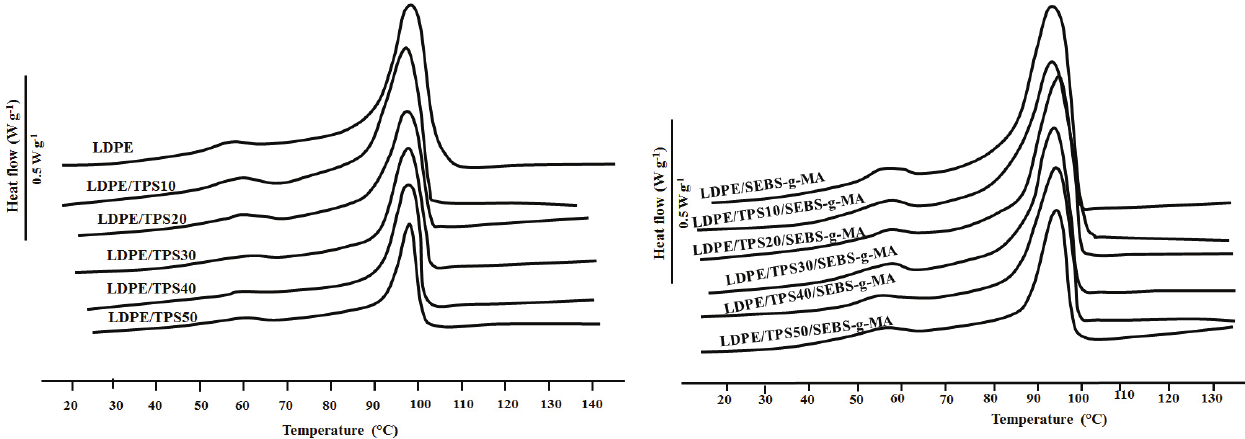
Fig. 5 – DSC cooling thermograms of LDPE/TPS/SEBS-g- MA